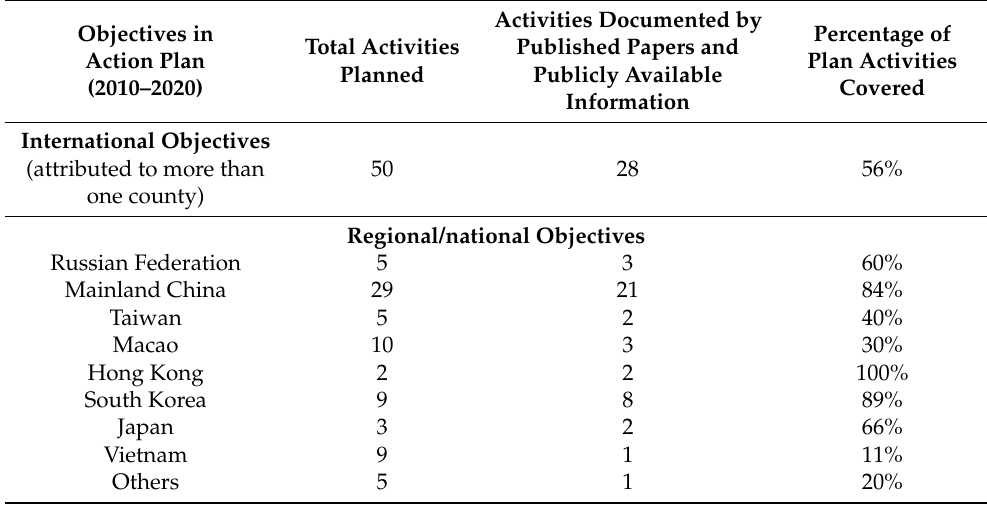
Table 1. Number of activities planned in the black-faced spoonbill single-action plan 2010–2020 compared to those documented by published papers and publicly available information as being implemented. The details of all planned activities are given in Tables S2 and